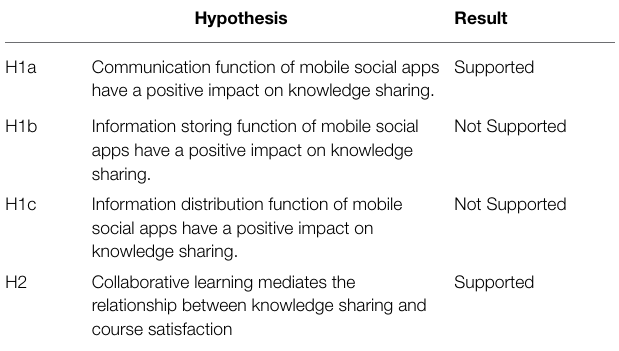
TABLE 5 | Overall